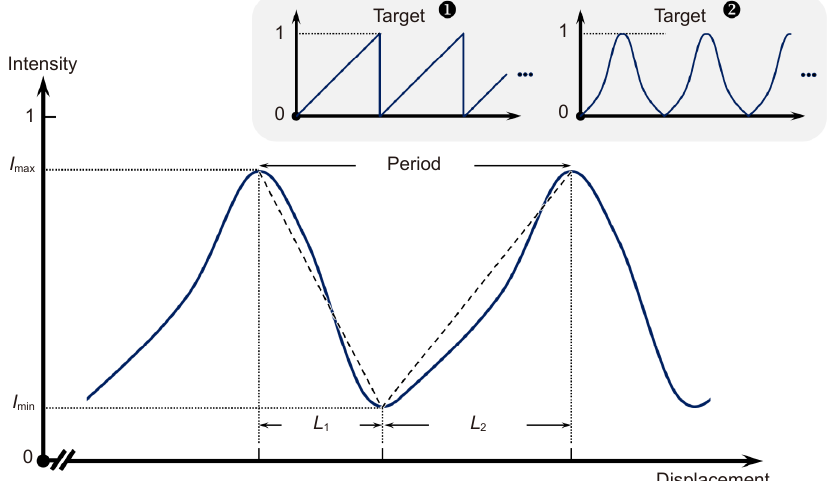
Fig. 4 | Illustration of the light intensity response as a function of displacement, and the target responses, a sawtooth-like curve and a perfectly symmetric response, are shown in the